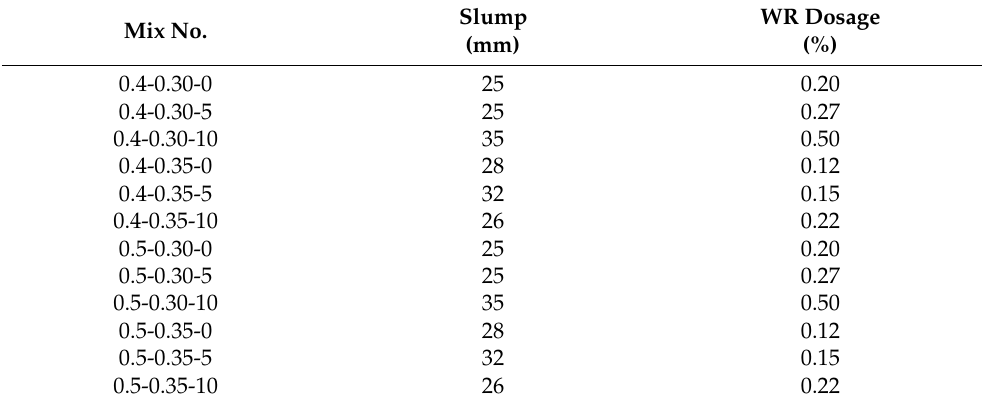
Table 2. Test results of paste portions. Mix